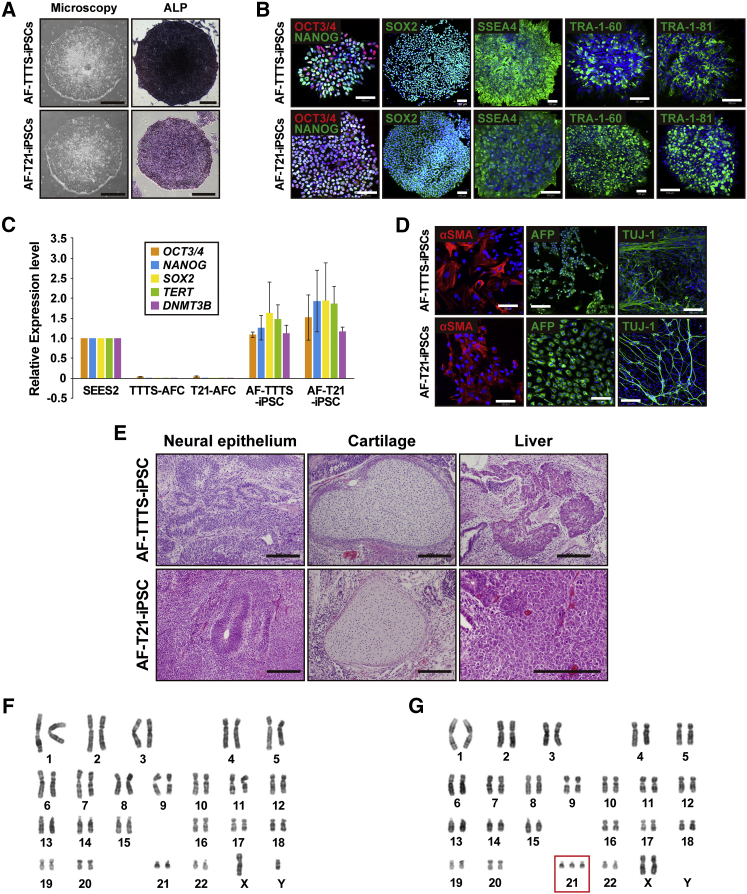
Generation of iPSCs from Patients with Down Syndrome T21 and Twin-Twin Transfusion Syndrome(A) Phase-contrast microscopic view of AF-TTTS-iPSC and AF-T21-iPSCs with embryonic stem cell (ESC)-like morphology growing on a feeder-free vitronectin surface (left panels). AF-TTTS-iPSCs and AF-T21-iPSCs are positive for alkaline phosphatase staining (ALP) (right panels). Scale bars, 500 μm.(B) Immunocytochemical analysis of stem cell markers, i.e., OCT3/4, NANOG, SOX2, SSEA-4, TRA-1-60, and TRA-1-81 in AF-TTTS-iPSC and AF-T21-iPSC colonies. AF-TTTS-iPSCs and AF-T21-iPSCs expressed these pluripotent markers. Nuclei were stained with DAPI (blue). Scale bars, 100 μm.(C) Real-time qPCR analysis of the endogenous expression levels of OCT3/4, NANOG, SOX2, TERT, and DNMT3B in AF-TTTS-iPSCs and AF-T21-iPSCs. The expression levels of these stem cell markers in AF-TTTS-iPSCs and AF-T21-iPSCs are comparable with those in human ESCs (SEES2). Values are shown as mean ± SD from three independent experiments.(D) In vitro differentiation of AF-TTTS-iPSCs and AF-T21-iPSCs into three germ layers. After EB formation, iPSCs were stained with antibodies to α-smooth muscle actin (αSMA) (a mesodermal marker), α-fetoprotein (AFP) (an endodermal marker), and βIII-tubulin (TUJ-1) (an ectodermal marker). Scale bars, 100 μm.(E) In vivo differentiation of AF-TTTS-iPSCs and AF-T21-iPSCs into three germ layers. Teratomas were harvested 6–8 weeks after subcutaneous injection of iPSCs into nude mice. Various tissues, such as neural epithelium (ectodermal), cartilage (mesoderm), and liver (endoderm), were found. Scale bars, 200 μm.(F) Karyotypic analysis in AF-TTTS-iPSCs. AF-TTTS-iPSCs had normal karyotypes (46, XY).(G) Karyotypic analysis in AF-T21-iPSCs. AF-T21-iPSCs had typical trisomy karyotypes (47, XX, +21).See also Figure S1.